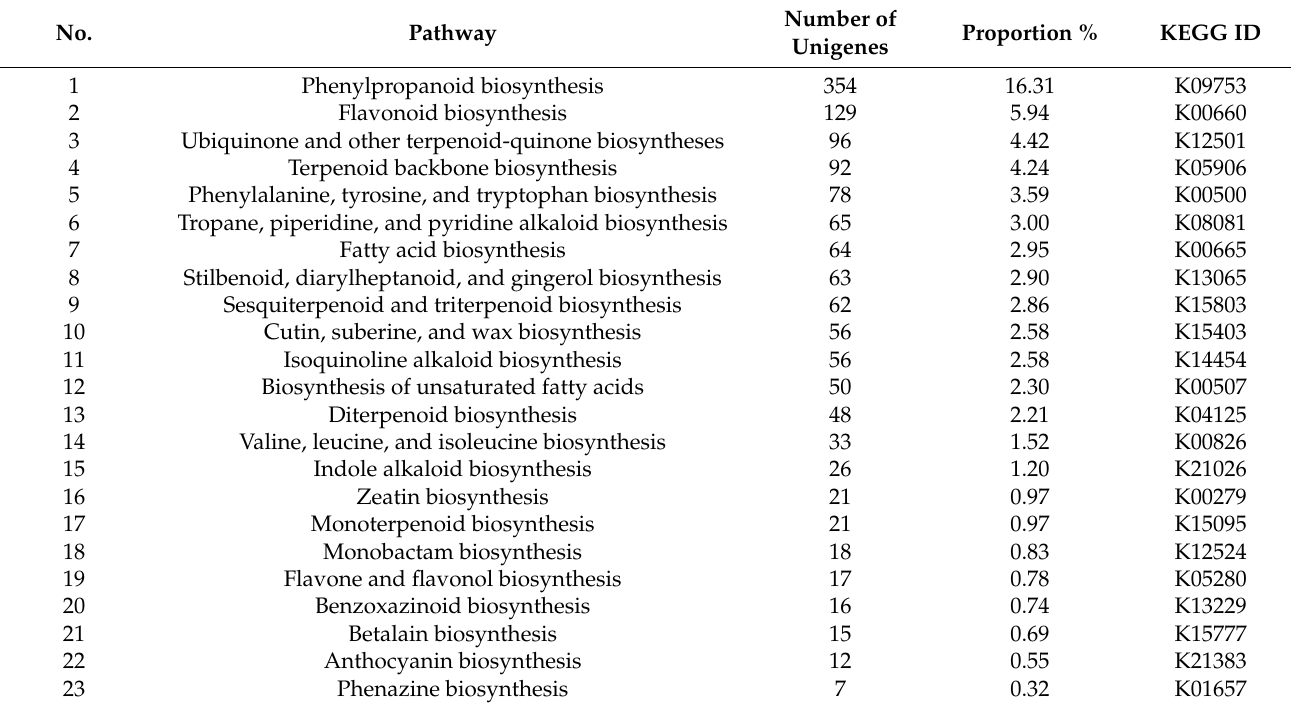
Table 1. The KEGG pathway annotation analysis of G. macrophylla transcriptomic unigenes associ- ated with secondary metabolism.